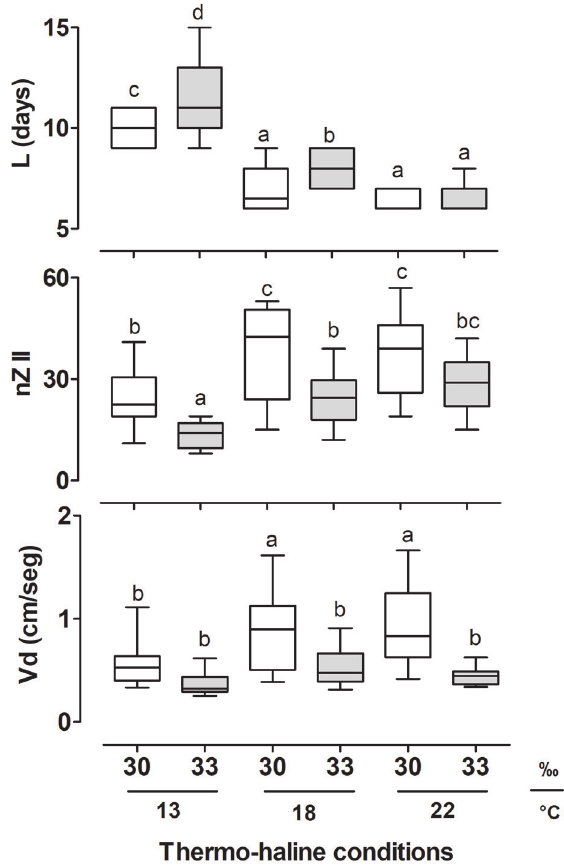
Figure 4. Length of Ovalipes trimaculatus Zoea I stage (L); number of zoeae achieving instar II relative to the number of zoeae I at the beginning of the experiment (nzII); speed of vertical displacements of the zoeae I (cm seg-1) in response to light stimulus (Vd) at different seawater temperature and salinity conditions. Different letters indicate significant statistical differences between mean L, nzII and Vd in Tuckey tests. Central mark in box plots represents the mean value; upper and lower box extremes show inter-quartile range of observed values; whiskers show maximum and minimum observed values. Shadowed boxes indicate 33‰ salinity